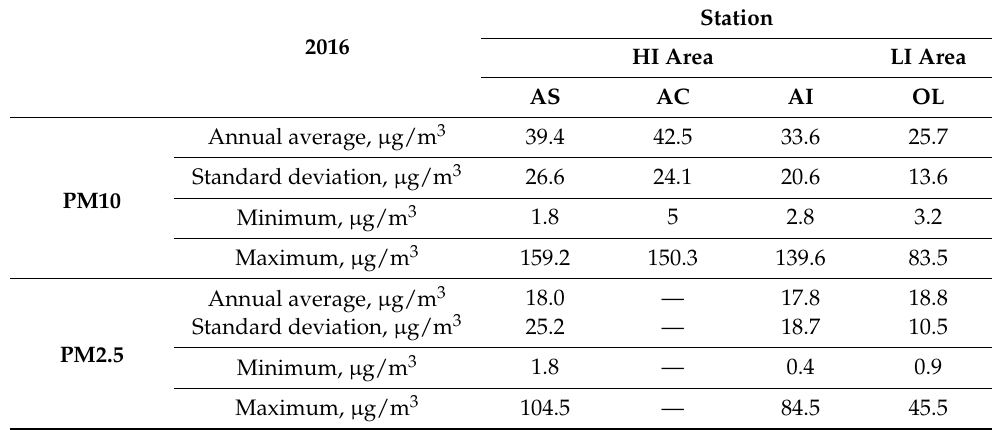
Table 3. PM10 and PM2.5 air quality indexes for HI and LI areas during